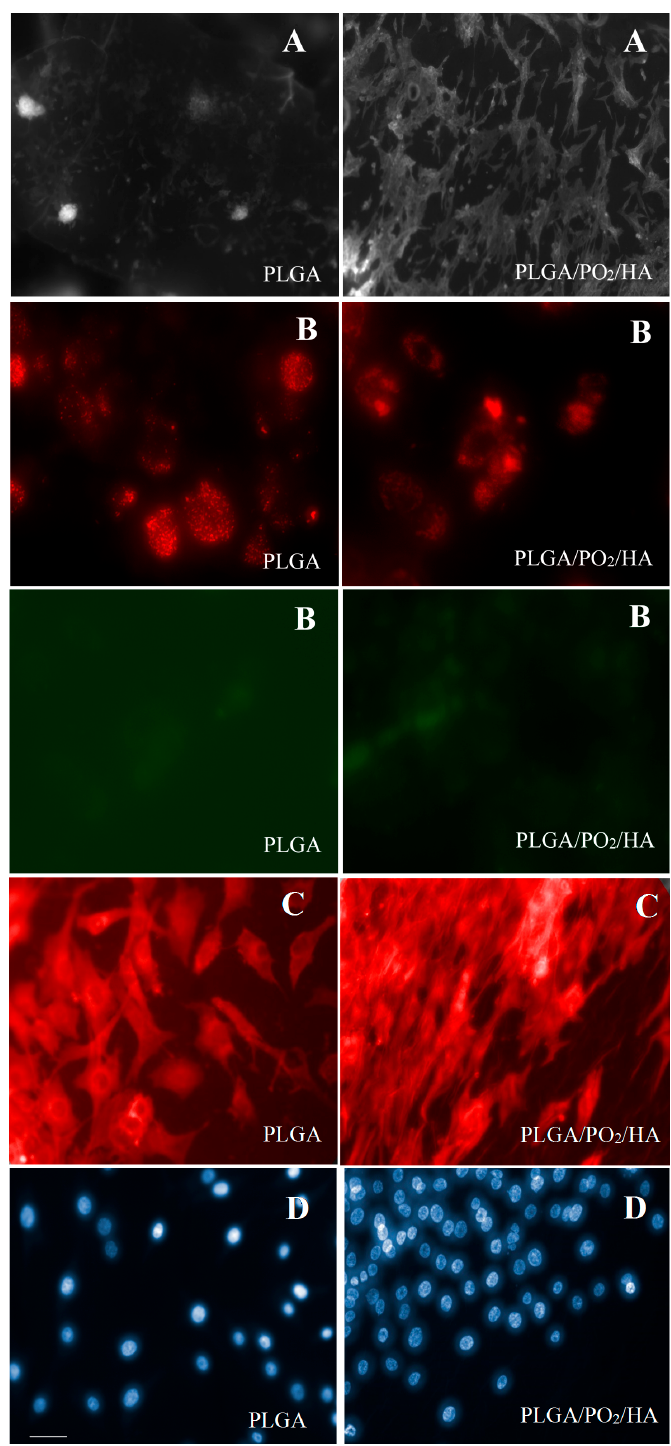
Figure 8. ( A ) Microphotography of osteoblasts on the membranes of PLGA and PLGA/PO 2 /HA; ( B ) JC-1 Probe Marking Microphotography; ( C ) Staining with phalloidina-TRITC 50 μ g/mL; ( D ) Staining with DAPI. Bar in D-PLGA = 10 microns (same scale for all images). Images taken with the fluorescence microscope Axio Observer A1 (Carl Zeiss).